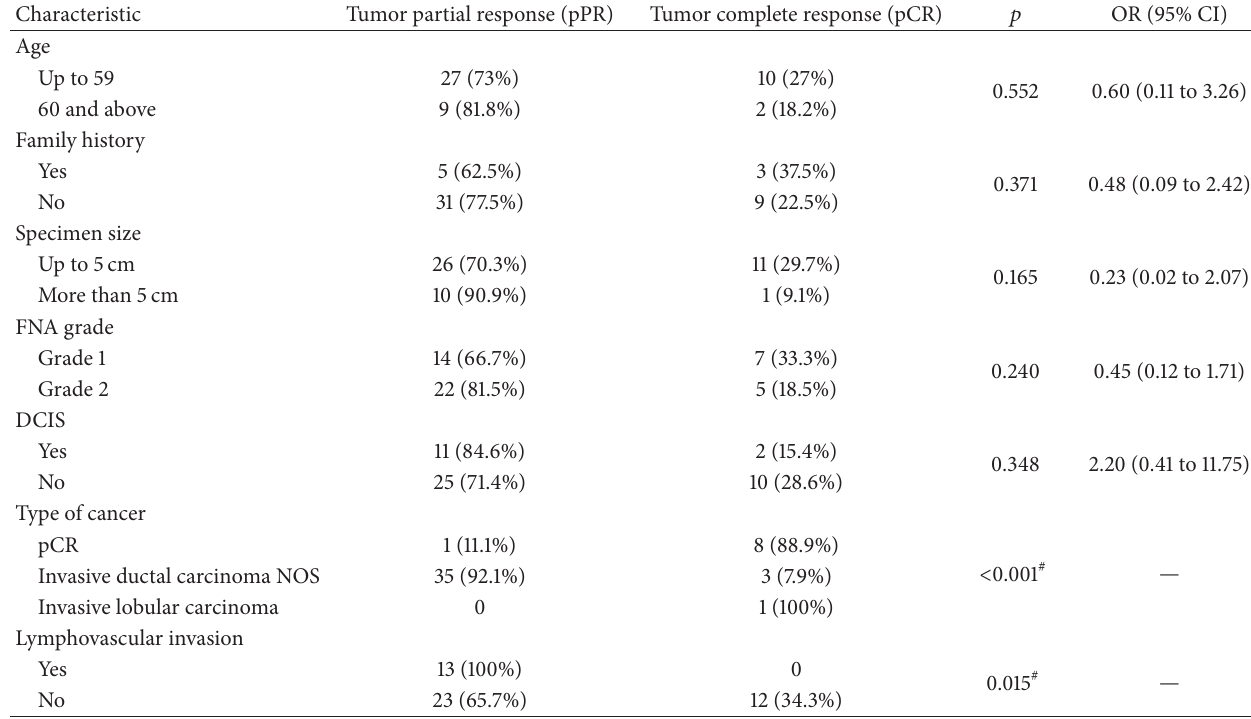
Table 6: Factors affecting the tumor response.